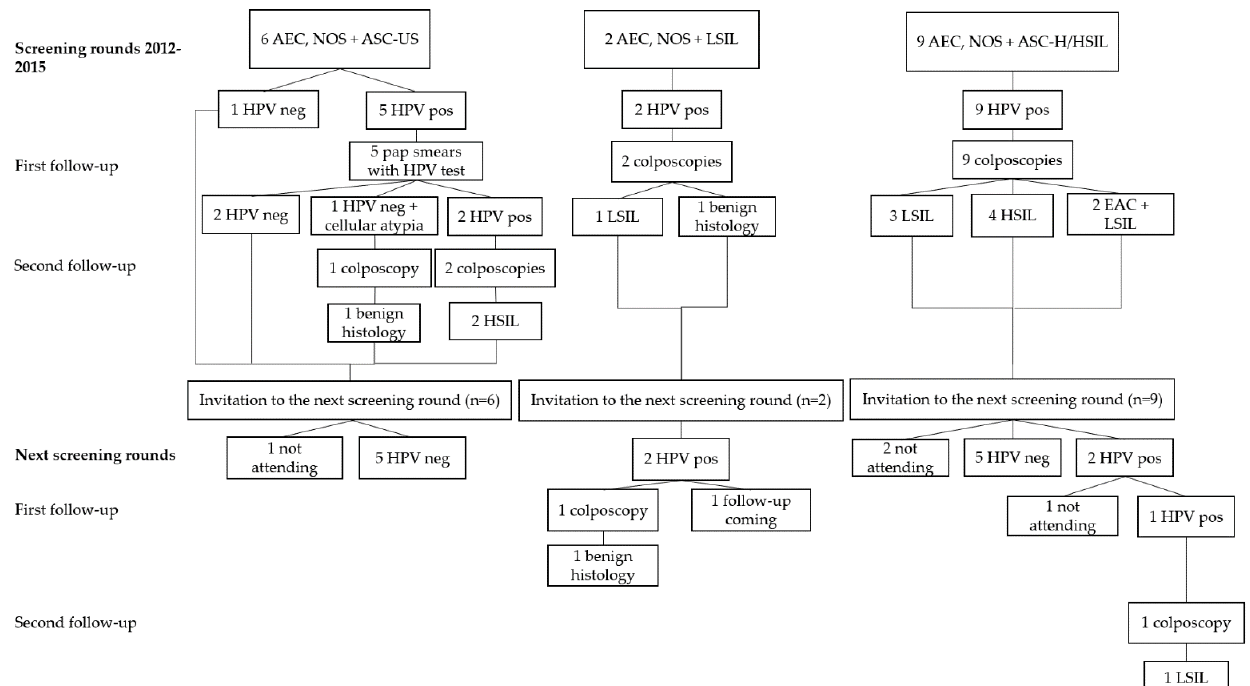
Figure 2. The outcome of two consecutive HPV primary cervical cancer screening rounds of patients with atypical endocervical cells, NOS and a squamous cell atypia in cytology. Abbreviations: AEC, NOS, Atypical Endocervical Cells, NOS; EAC, Endocervical Adenocarcinoma; ASC-US, Atypical Squamous Cells, Undetermined Significance; LSIL, Low-Grade Squamous Intraepithelial Lesion; HSIL, High-Grade Squamous Intraepithelial Lesion; ASC-H, Atypical Squamous Cells, Cannot Exclude an HSIL; HPV, human papillomavirus; pos, positive; neg, negative. Combinations of abbreviations representing cytological diagnoses: AEC, NOS + ASC-US; AEC, NOS + LSIL; AEC, NOS + ASC-H/HSIL. Abbreviations representing histological diagnoses: LSIL; HSIL; EAC + LSIL.